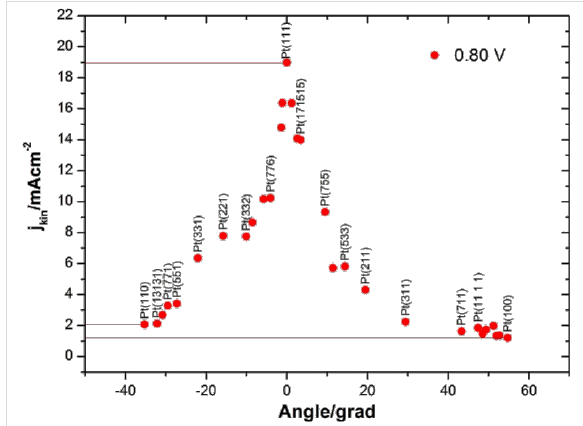
Figure 6: Plot of the kinetic currents at 0.8 V, j kin (0.8 V), for the oxygen reduction as a function of the angle of the surface with respect to Pt single crystals, basal planes and stepped surfaces, in 0.1 M NaOH